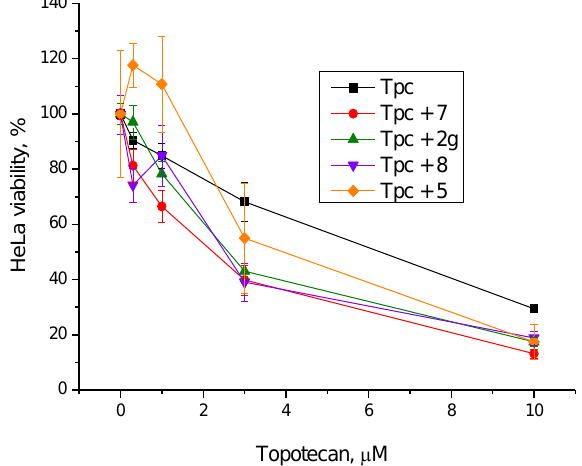
Figure 3. Dose-dependent action of topotecan (Tpc) in combination with one of the nucleoside derivatives on HeLa cell viability in the EZ4U assay.